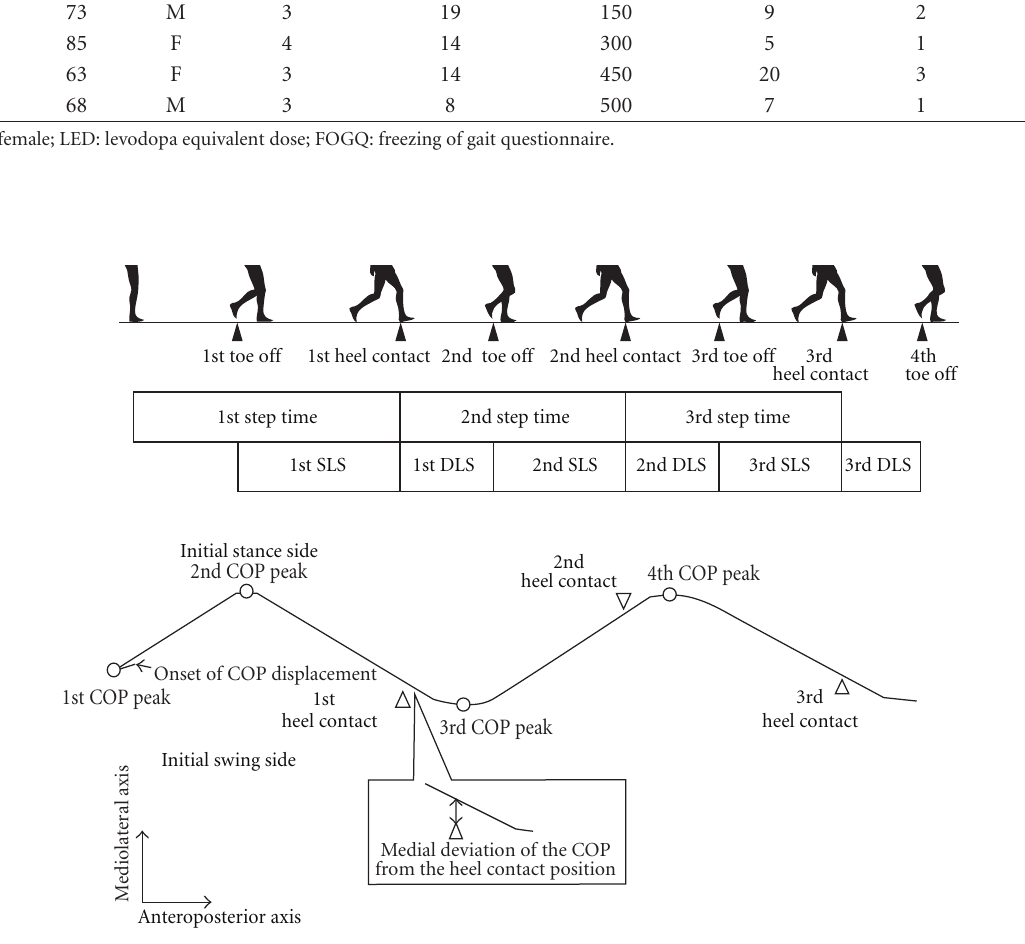
Figure 1: Spatiotemporal and kinesiological parameters. A trace in the middle of the figure indicates the COP trajectory. Open circles indicate COP peaks. Open triangles indicate heel contact